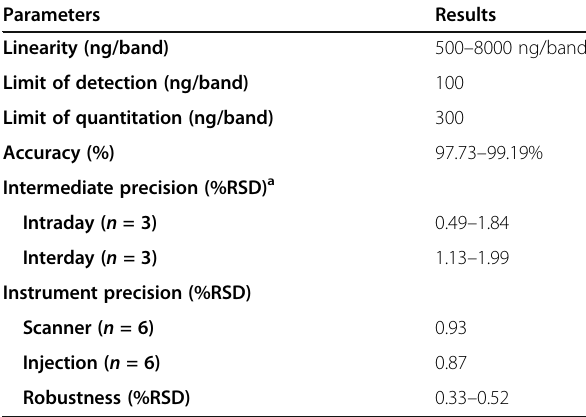
Table 3 Summary of validation parameters